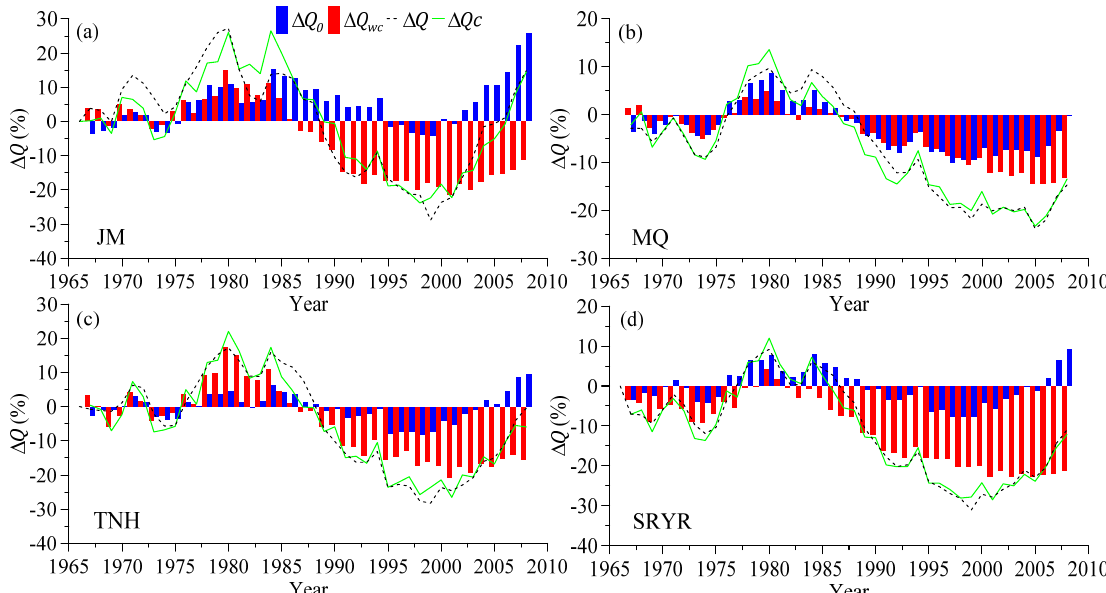
Figure 6. Decomposition results of the climatic change in discharge (Δ Q 0 , Δ Q wc , and Δ Q c ) in comparison with the total change in discharge (Δ Q ) for the three sub‐basins and the source region of the Yellow River (SRYR). ( a – d ) The results of using Equation (8) for Jimai (JM), Maqu (MQ), Tangnaihai (TNH), and the SRYR.